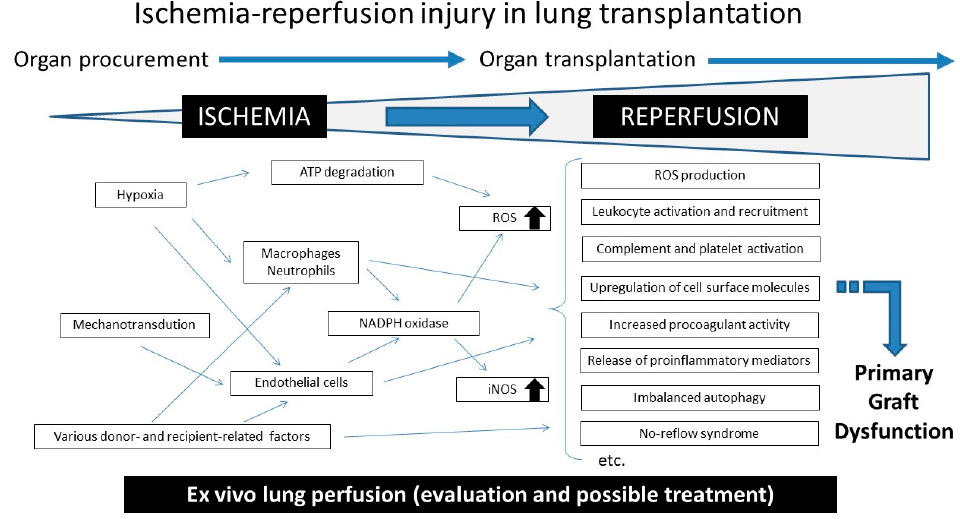
Figure 1. Scheme of ischemia–reperfusion injury in lung transplantation. Autophagy promotes cell survival by allowing the regular degradation and recycling of cellular components; however, an imbalance in endosomal and autophagic pathways lungs during IRI, and inhibition of autophagy might alleviate pulmonary IRI. Suppression of mitochondrial autophagy by 3-methyladenine inhibits the apoptosis of endothelial cells and enhances their proliferation via the mechanistic target of rapamycin pathway [30]. 4. Strategies to Prevent Ischemia–Reperfusion Injury PGD occurs in approximately 10% of transplant recipients. It is associated with a mortality rate of 42% in the month after transplantation, which is sevenfold higher than that in patients without PGD [31]. Pulmonary IRI after lung transplantation is the main reason for PGD, which is also a major risk factor for the development of chronic lung allograft dysfunction (CLAD) [32,33]. Therefore, various strategies to reduce pulmonary IRI after lung transplantation have been conducted in the clinical setting. One of the major challenges in lung transplantation is the shortage of acceptable do- nor lungs, with a low utilization rate of donated lungs of approximately 20% worldwide [34,35]. To counter this severe donor shortage, marginal donor lungs have been used. Mar- ginal donor lungs are lungs that may be transplantable but do not meet the criteria for ideal donor lungs, such as a ratio of arterial partial pressure of oxygen to fraction of in- spired oxygen (PaO 2 /FiO 2 ) of > 300 mmHg, absence of infiltration on chest radiographs, clear bronchoscopic findings, and absence of a smoking history [3,36]. The first step in preventing PGD is to eliminate or reduce potentially modifiable risk factors; thus, it is important to understand the risk factors for PGD of both donors and recipients. Second, the greatest efforts have been focused on the method of reperfusion and ventilation of lung grafts in addition to lung preservation. Prolonged ischemic time is associated with a significantly higher risk of PGD; however, surgical and anesthetic considerations are also crucial in PGD prevention [10]. Attempts to reduce the develop- ment of PGD have included shortening the ischemic time, controlling reperfusion, using protective ventilation, and using various medications for modulating the IRI pathways [37,38]. 4.1. Donor and Recipient Factors Multiple clinical factors related to an increased risk of PGD development have been reported. Among donor-inherent variables, age (>45 or <21 years) and female sex were reported to be clinical risk factors for PGD [39]. Premortem hypoxemia/hypotension and